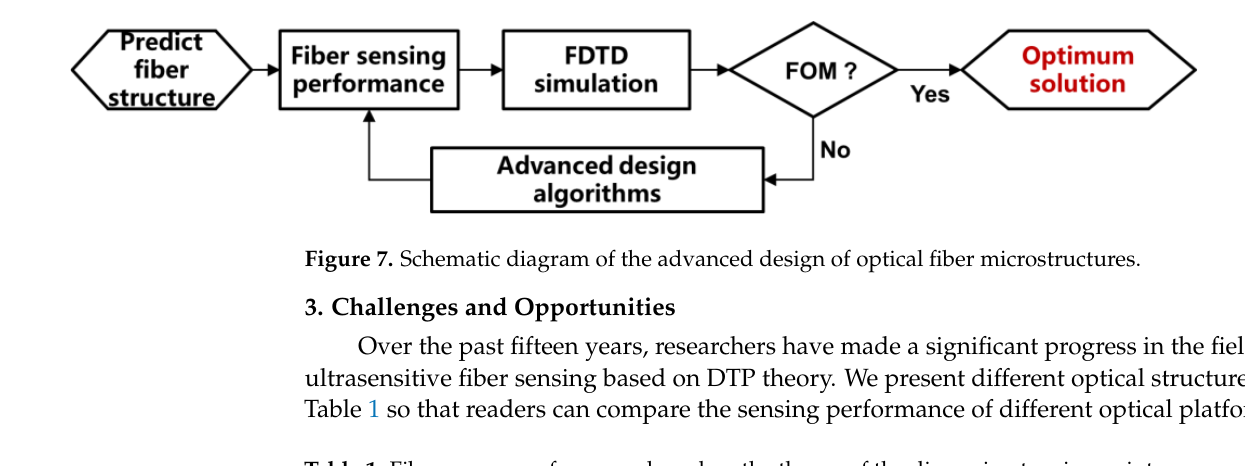
Table 1. Fiber sensor performance based on the theory of the dispersion turning